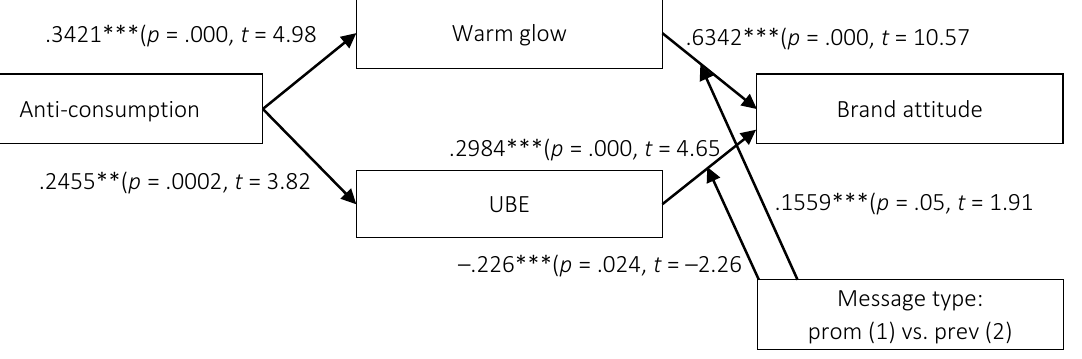
Figure 2. The results of the analysis of the entire